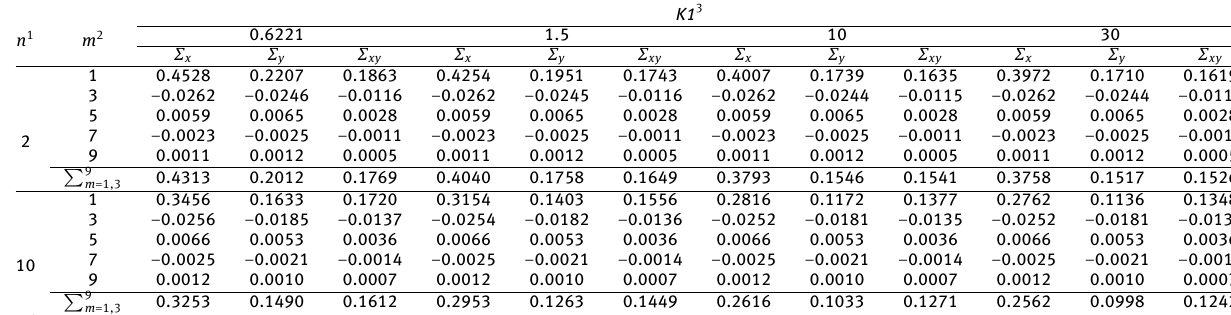
Table 4: Effect of the beam stiffness, K1 , on the convergence of stresses Σ ( a /2, a /2) = ( h 2 / qa 2 ) σ at the center of an antisymmetric angle- ply square plate (30 ∘ /-30 ∘ /30 ∘ /-30 ∘ / . . . ) having three edges simply supported and the fourth edge ( x = a ) beam supported ( a / h =